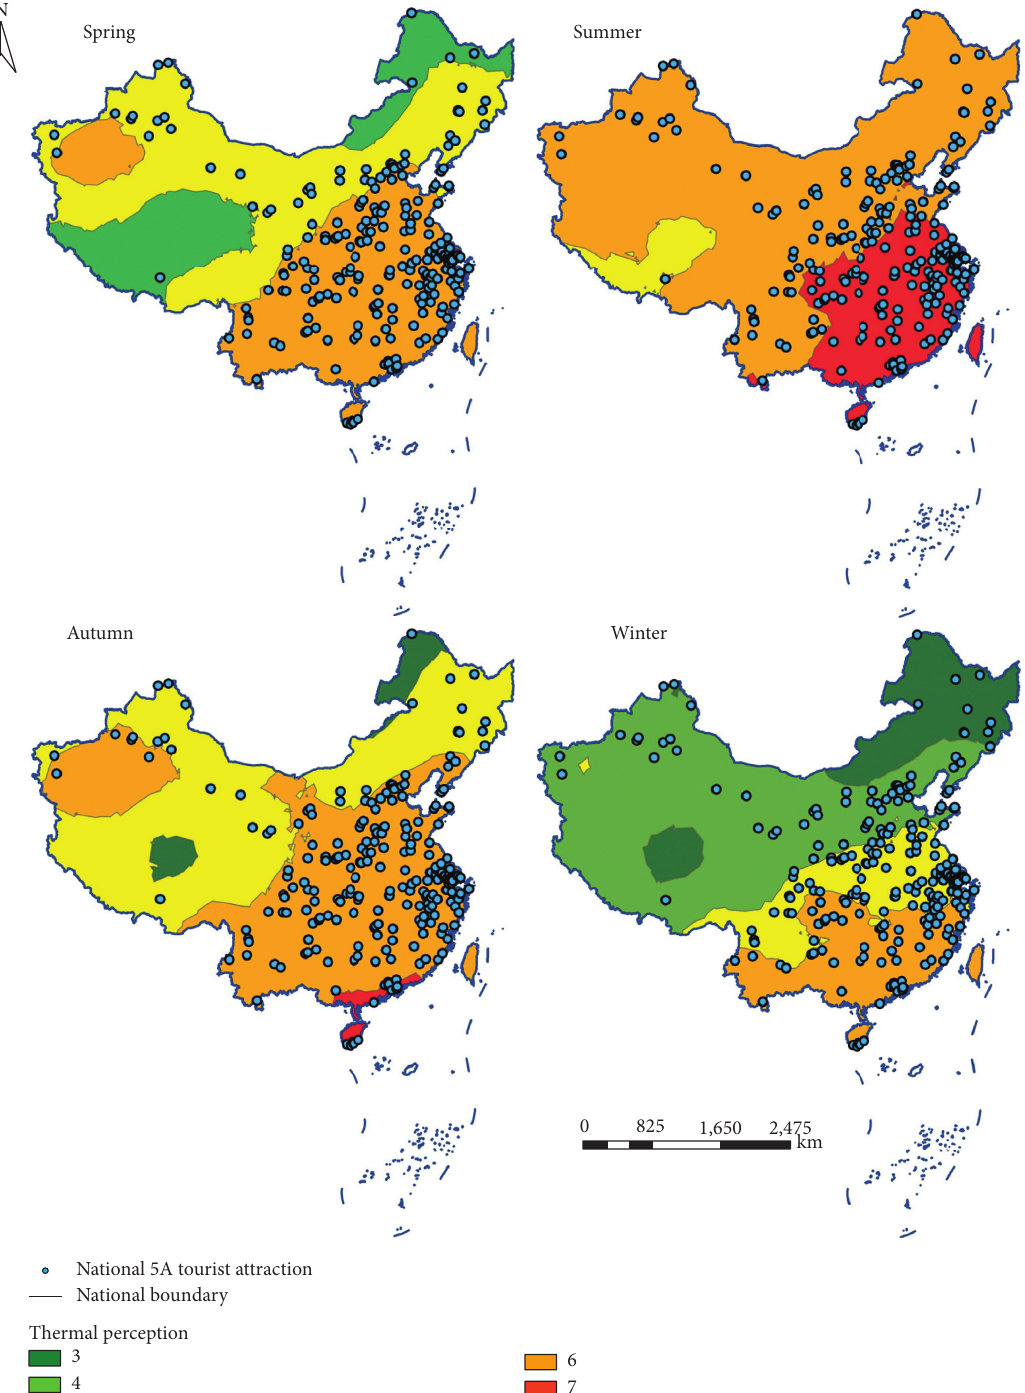
Figure 3: Spatial distribution of climate comfort levels of national 5A tourist attractions with respect to